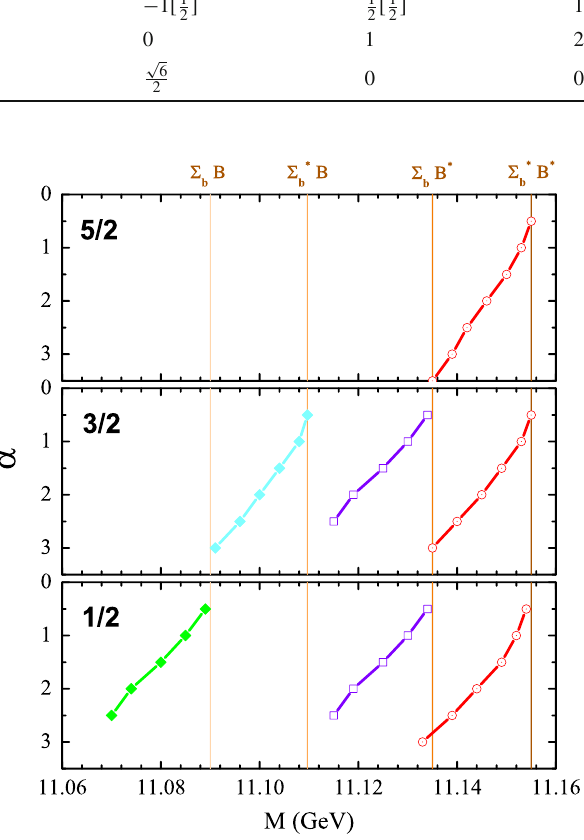
Fig. 1 The α dependence of the mass M of isodoublet binding states from single-channel interaction. The four solid lines from right to left represent the thresholds of four channels Σ ∗ at 11155 MeV, 11135 MeV, 11110 MeV and 11090 MeV, respectively. The curves are for the bound states from the interactions with corre- sponding